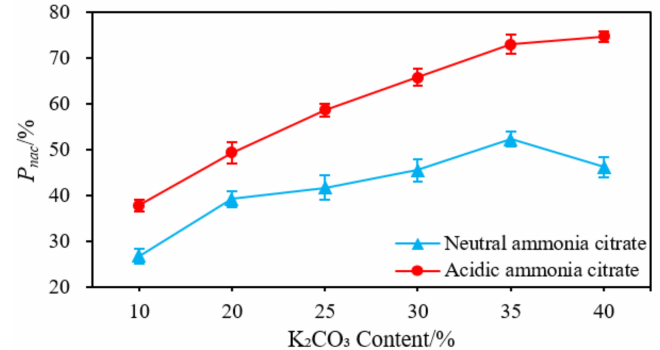
Figure 9. Bioavailable phosphorous in SSA improved by K 2 CO 3 calcination in air at 950 ◦ C.